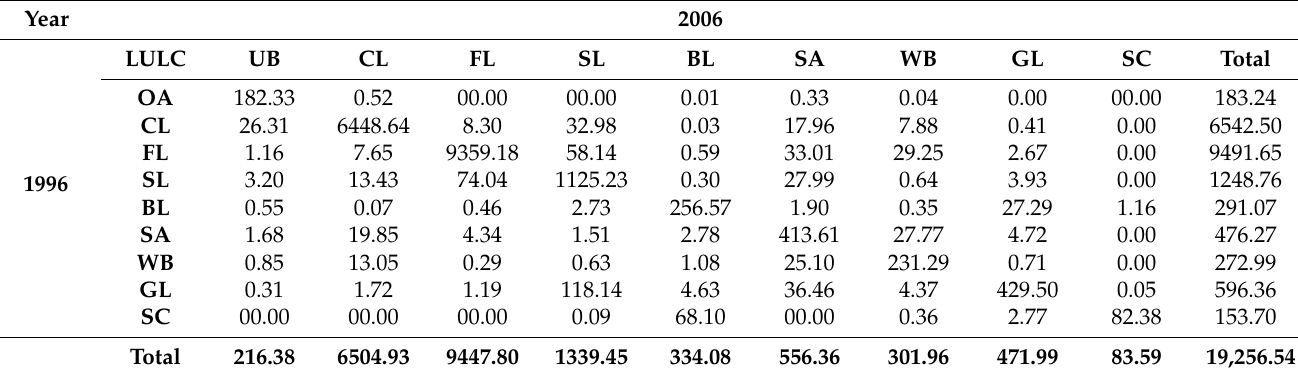
Table 5. LULC transition from 1996 to 2006.